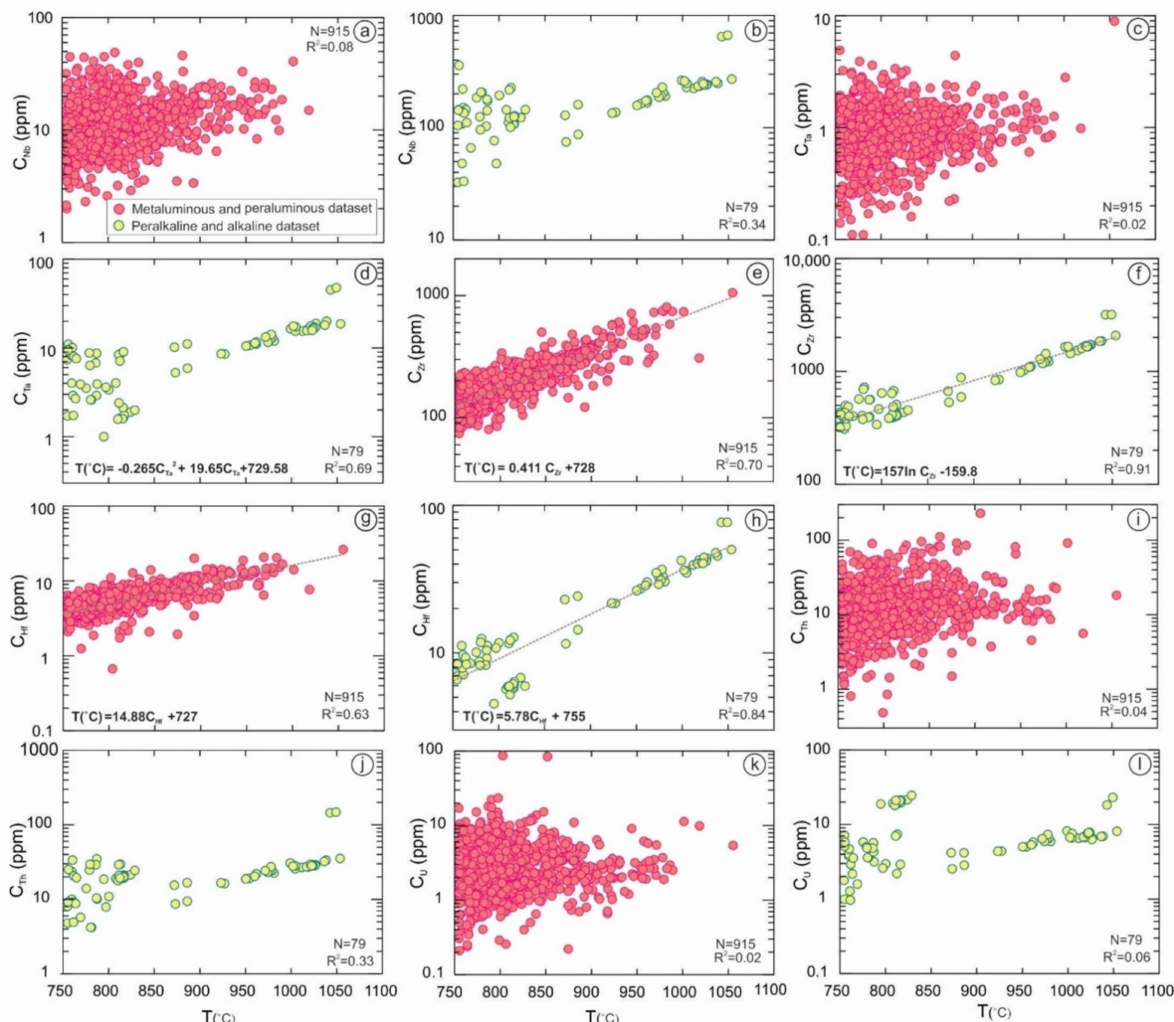
Figure 4. ( a , b ) Nb versus the temperature ( a ) in the metaluminous to peraluminous rocks, ( b ) Peralka- line to the alkaline dataset. ( c , d ) C Ta versus the temperature ( c ) in metaluminous to the peraluminous dataset, ( d ) in peralkaline to the alkaline dataset. C Nb is not correlated to the temperature but Ta ∝ T in the peralkaline to the alkaline dataset. C Zr versus the temperature ( e ), in metaluminous to the peraluminous dataset, ( f ) in peralkaline to alkaline Plot C Hf versus the temperature ( g ) in metalumi- nous to the peraluminous dataset, ( h ) in peralkaline to the alkaline dataset. The pattern shows that the temperature in whole rocks has a strong positive relationship with Zr and Hf in both